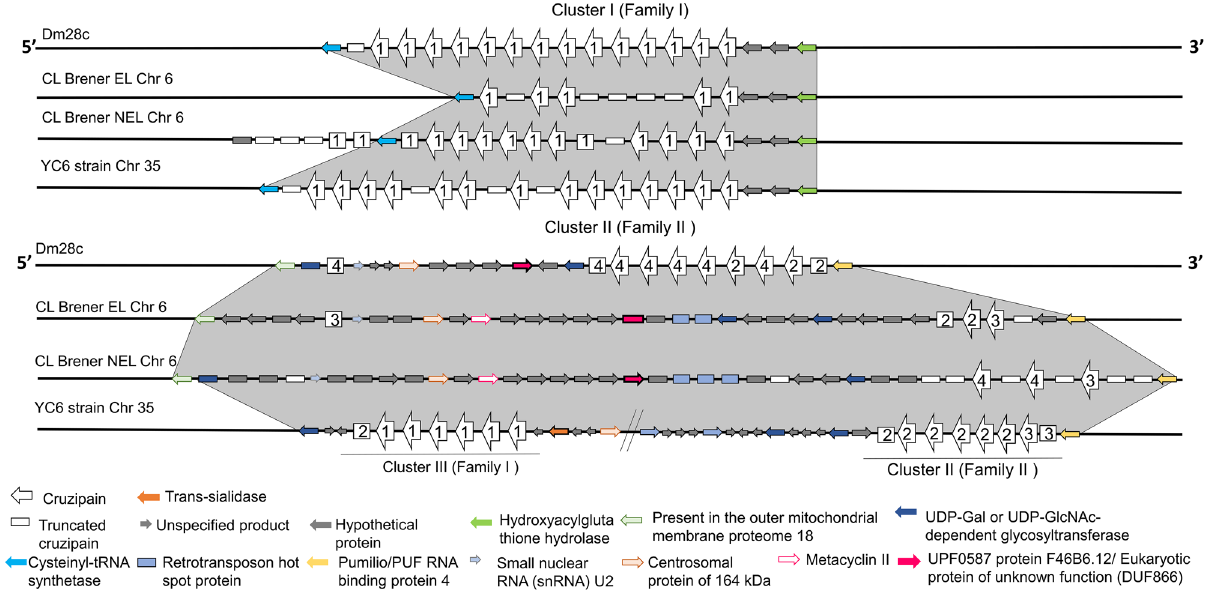
Figure 4. Representation of the syntenic cruzipain clusters in T. cruzi chromosomes. The homologous chromosomes of the Dm28c and YC6 strains are identical and represented once, while for the hybrid CL Brener strain, the two alleles corresponding to the Esmeraldo-like (EL) and non-Esmeraldo-like (NEL) haplotypes are represented separately. In each cluster, cruzipain copies are shown as white arrows, numbered according to the sub-type to which they belong, while truncated cruzipain copies are shown as white rectangles. The cruzipain clusters of the YC6 strain are found on chromosome 35 (Chr 35), and on chromosome 6 (Chr 6) for CL Brener. Genes are represented from 5’ to 3’ (genomic), and the arrows point in the predicted transcription direction. The genomic sequences were manually curated to search for full length and truncated copies that are represented here and might not match current annotation of cruzipain genes in